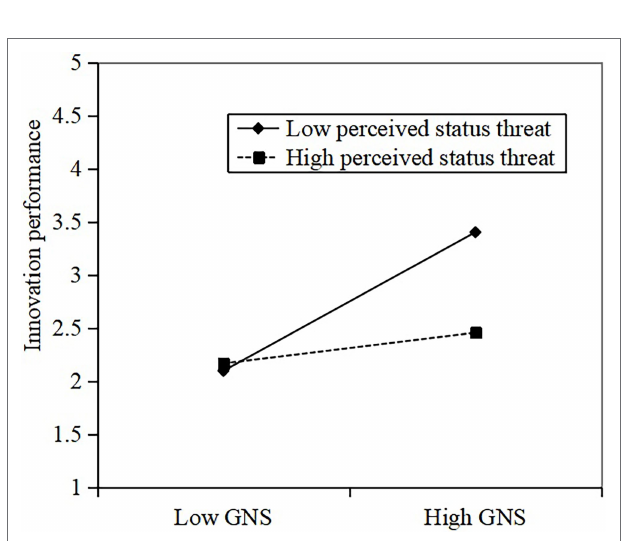
FIGURE 3 | Interaction impacts of GNS and perceived status threat on innovation